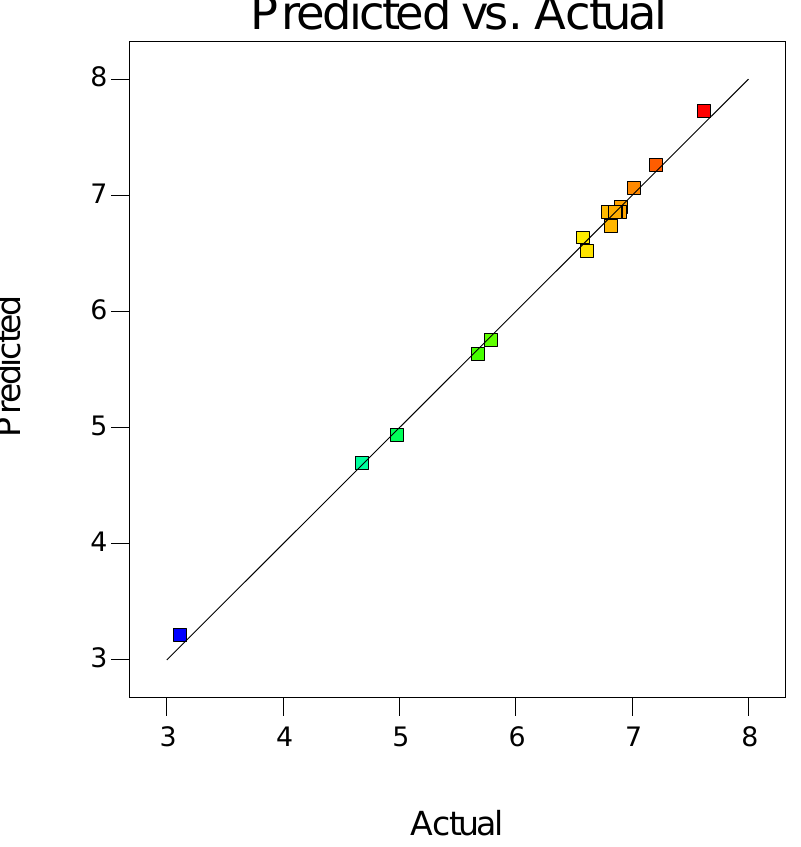
Figure 5. Comparison diagram of the predicted values and the actual values. The results showed that the values predicted by the model were very close to the actual measured values and contained only minor errors, which further confirmed that the model had a high degree of fit and was the ideal model. (3) Response Surface and Contour Diagram Analysis The three-dimensional response surface diagram and the corresponding contour diagram were established to better understand the impact of the influencing factor variables and their interactions with each other. The results are shown in Figures